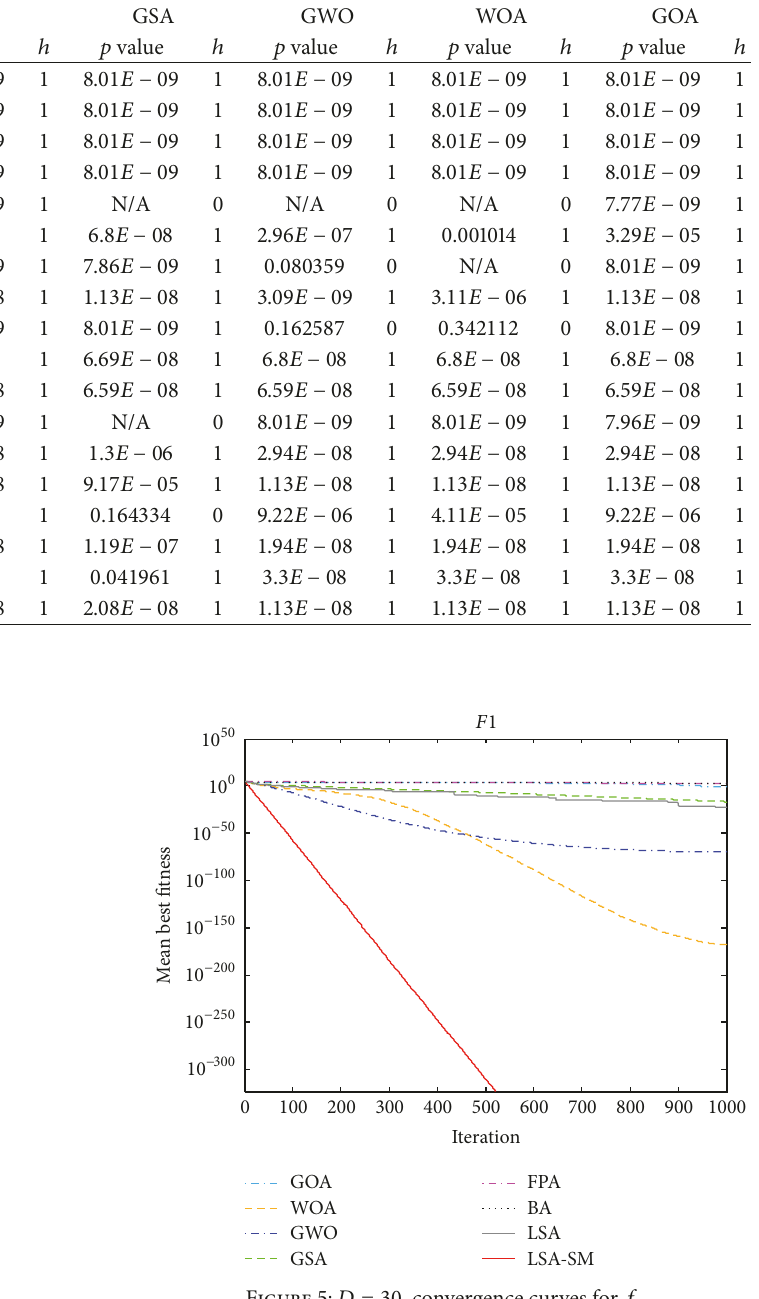
Figure 5: 𝐷 = 30 , convergence curves for 𝑓 01